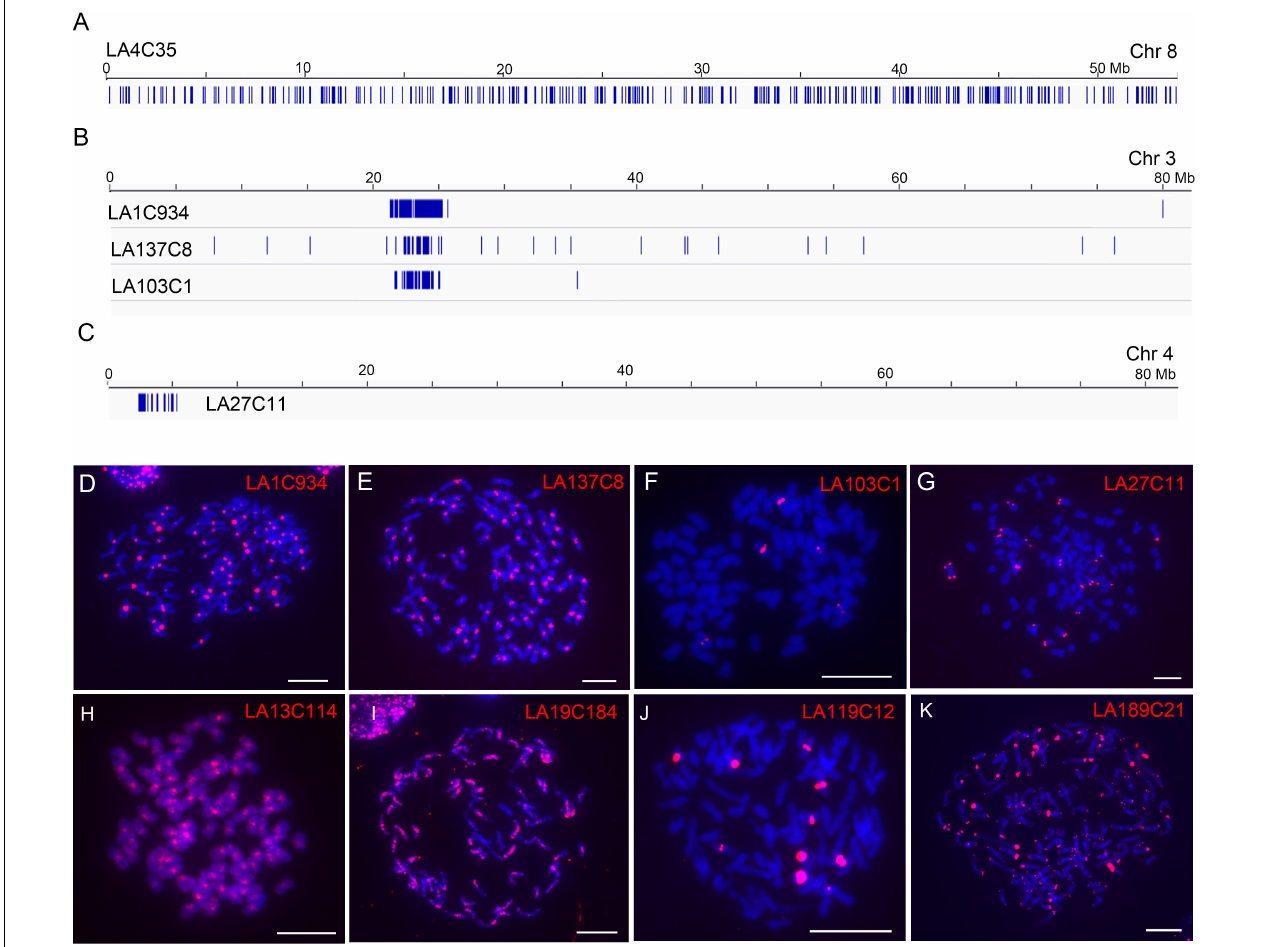
FIGURE 2 | Characterization of genomic distributions of representative repeats in LA Purple. (A–C) Diagrams illustrate the distributions of repeats LA4C35, LA1C934, LA137C8, LA103C1, and LA27C1 in assembled pseudochromosomes. Blue bars represent homologous copies of the repeat. (D–K) FISH analyses of representative repeats in LA Purple. Eight repeats, LA1C934 (D) , LA137C8 (E) , LA103C1 (F) , LA27C11 (G) , LA13C114 (H) , LA19C184 (I) , LA119C12 (J) , and LA189C21 (K) , were mapped to the metaphase chromosomes. Bars = 10 µ